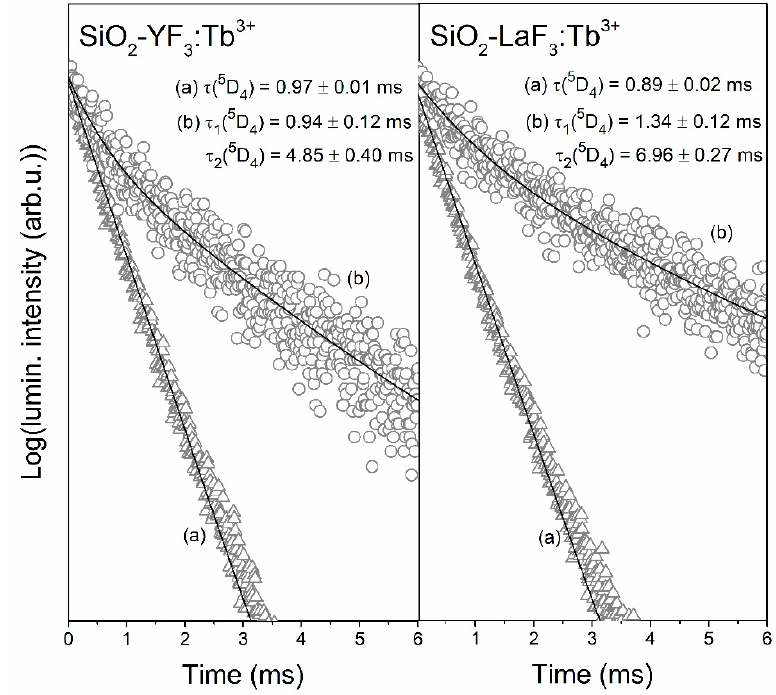
Figure 9. Luminescence decay curves of the 5 D 4 state of Tb 3+ recorded for xerogels ( a ) and glass- ceramics ( b ) singly doped with Tb 3+ ions.